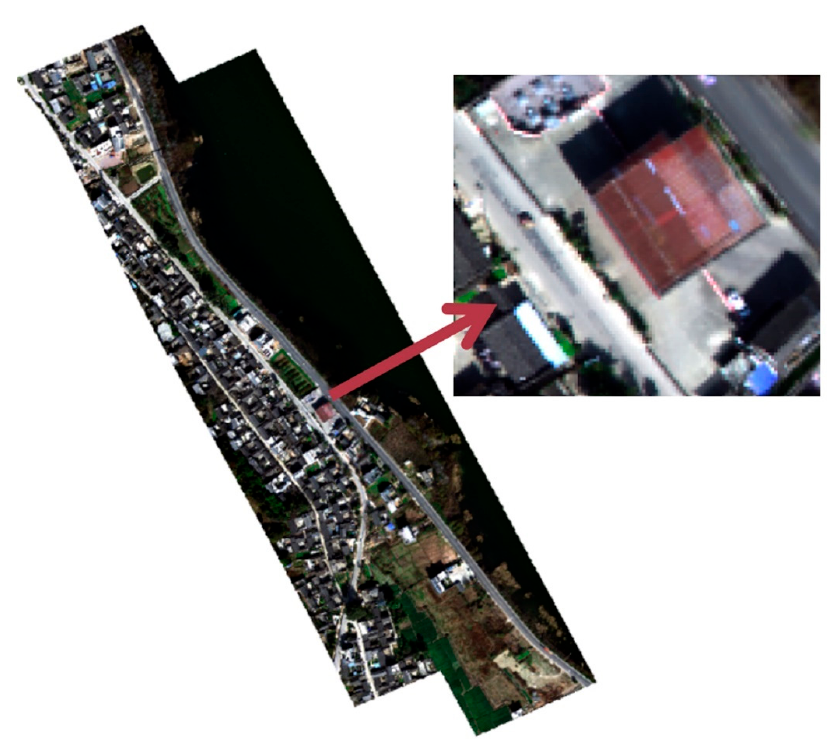
Figure 9. The weighted average fusion result of a urban scape area.